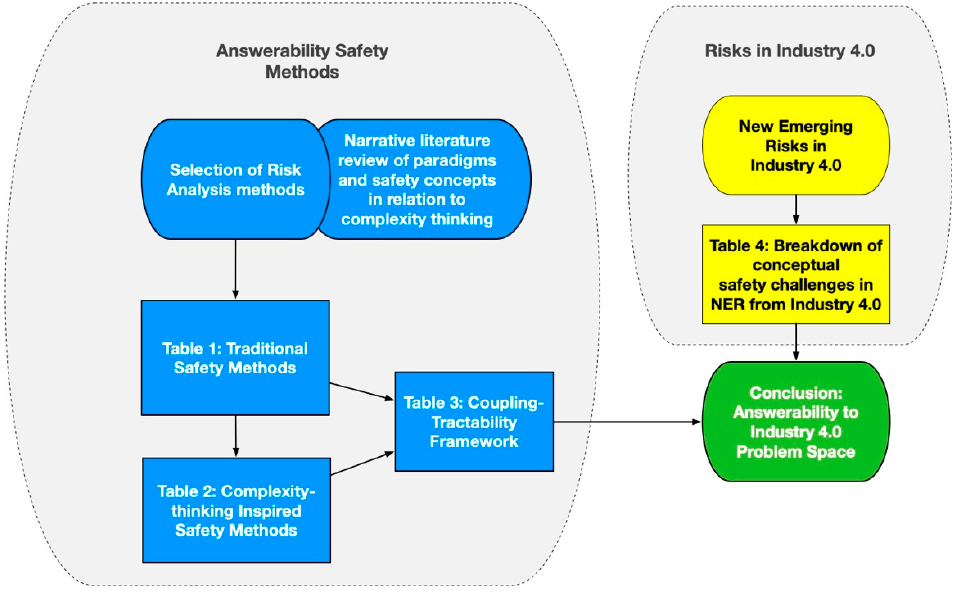
Figure 1. Figure 1. Methodology.